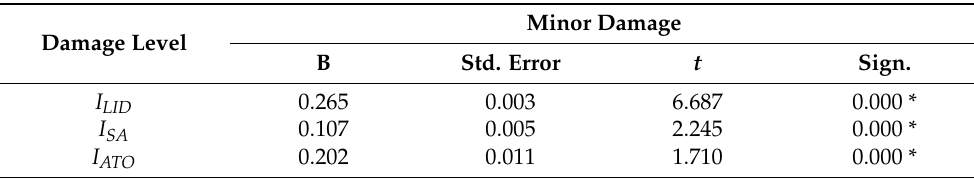
Table 6. Detailed multiple regression models (OLS) for LISA bidimensional analysis of the different levels of